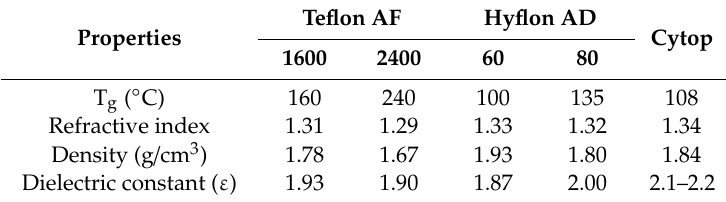
Figure 2. Chemical structure of the cyclic perfluoropolymer, Cytop TM . Table 1. Physical Properties of Teflon AF, Hyflon AD, and Cytop.